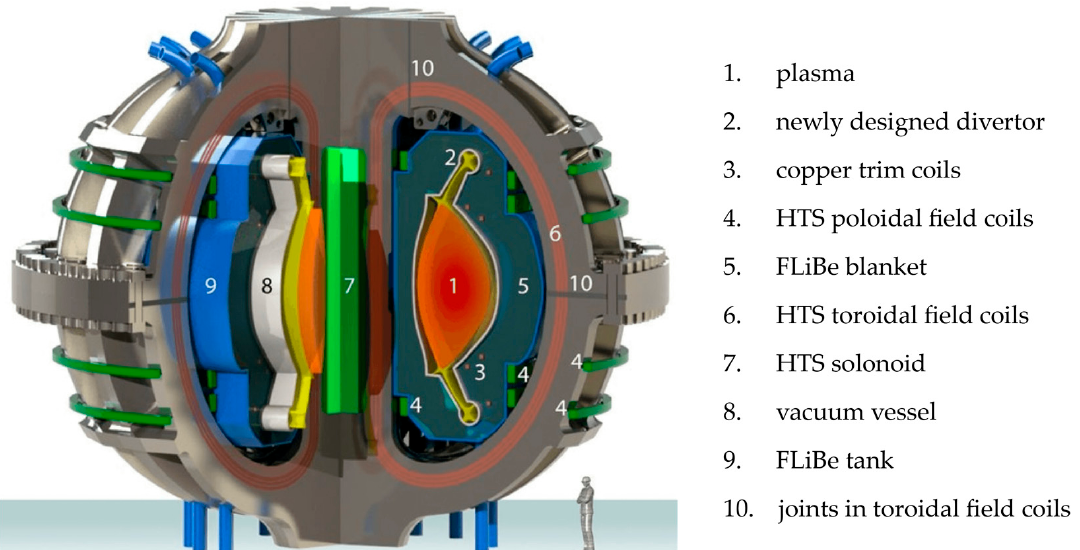
Figure 12. Conceptual design for the PEXS on the divertor leg. 3.2.2. Fluid surface The construction assumed each fin is attached to an upper cross-fin, as shown in Fig- ure 1, at a 90° angle, contrary to the geometry in Figure 1. This was chosen to simplify manufacturing and assembly. Consequently, it presented an undesired thermal bridge to the upper channels. Thermal bridging was limited by attaching every other lower-channel fin with an upper-channel fin, resulting in a “ ∩ -type” of lower-channel geometry. Figure 13 below shows a cross-section (a) and perspective (b) of the ∩ -type lower channel.